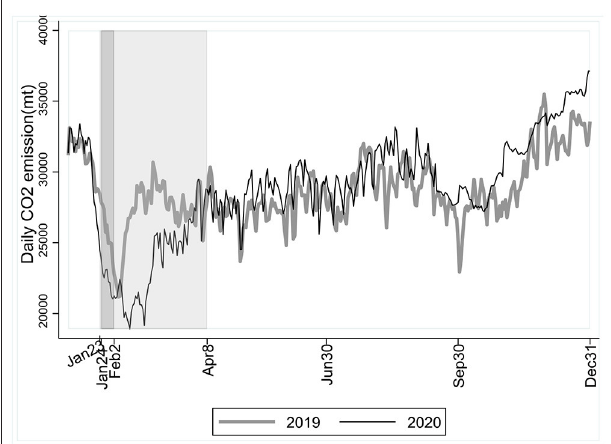
FIGURE 1 | China’s daily CO 2 emissions in 2019 and 2020, based on datasets by Carbon Monitor covering emissions from sectors of power, industry and cement production, ground transport, aviation, international shipping, residential, and commercial buildings. The dark-shaded area illustrates the lunar new-year break, while the light-shaded area illustrates the lockdown of Wuhan City, quite a representative of the first wave of the pandemic in China.